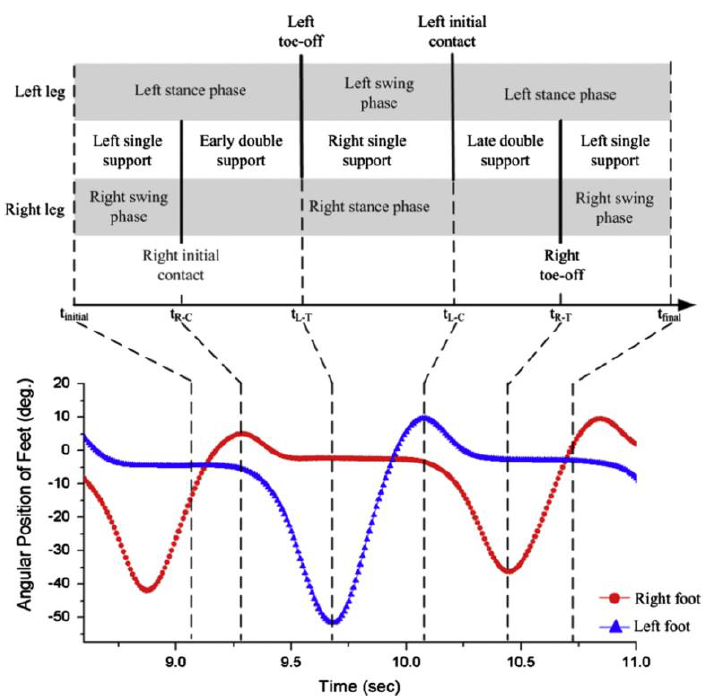
Figure 4. Identification of gait phases from the angular position of the feet, according to [44].